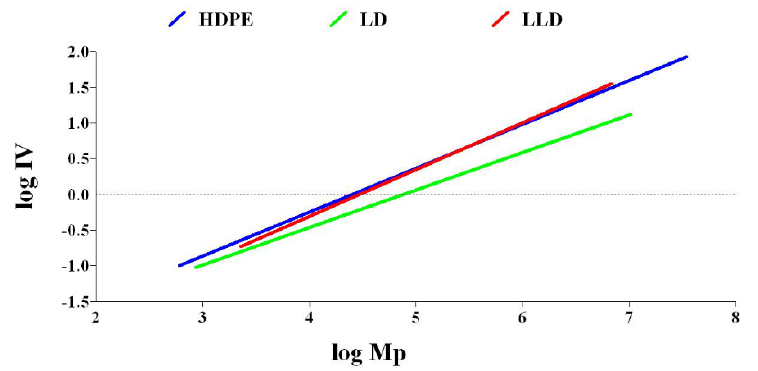
Figure 6. Diagram of log intrinsic viscosity vs. log molecular weight for polyethylenes.